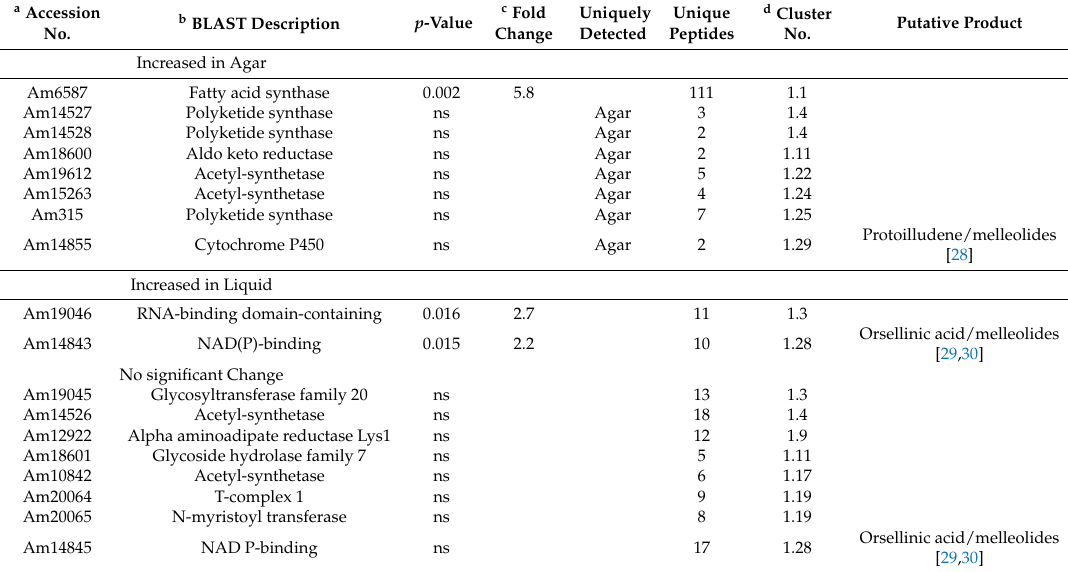
Figure 2. Volcano plot displaying quantitative data from the comparison between proteins detected in liquid and agar cultures of A. mellea . Proteins significantly increased in abundance ( p < 0.05) and with a fold change greater than two are depicted in colour. Red circles indicate proteins increased in agar extracts, and green circles indicate proteins with a higher abundance in extracts from liquid cultures. Table 2. Differential abundance of putative secondary metabolism-related proteins identified in liquid and/or agar cultures of A. mellea